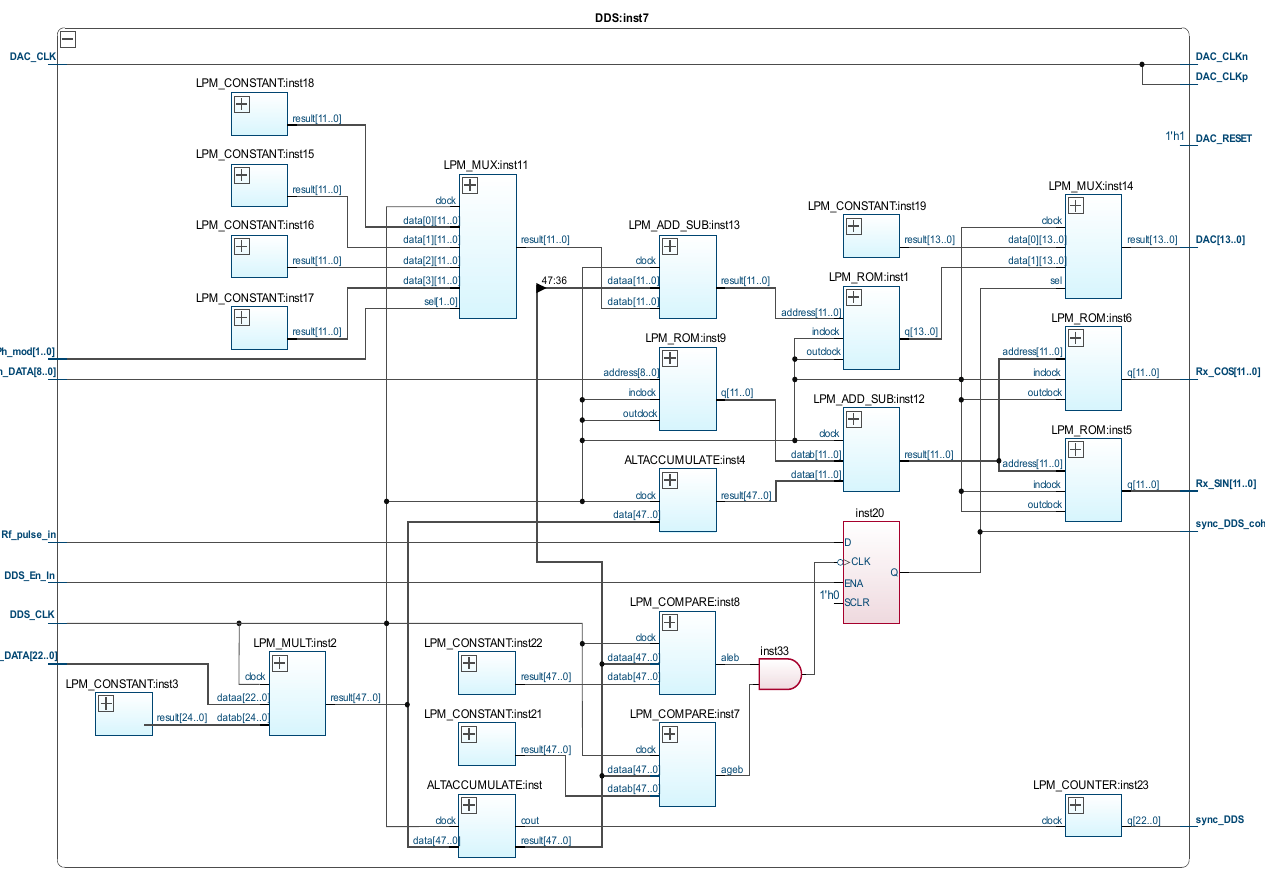
Figure 5. Configuration structure of digital frequency synthesizer based on FPGA.